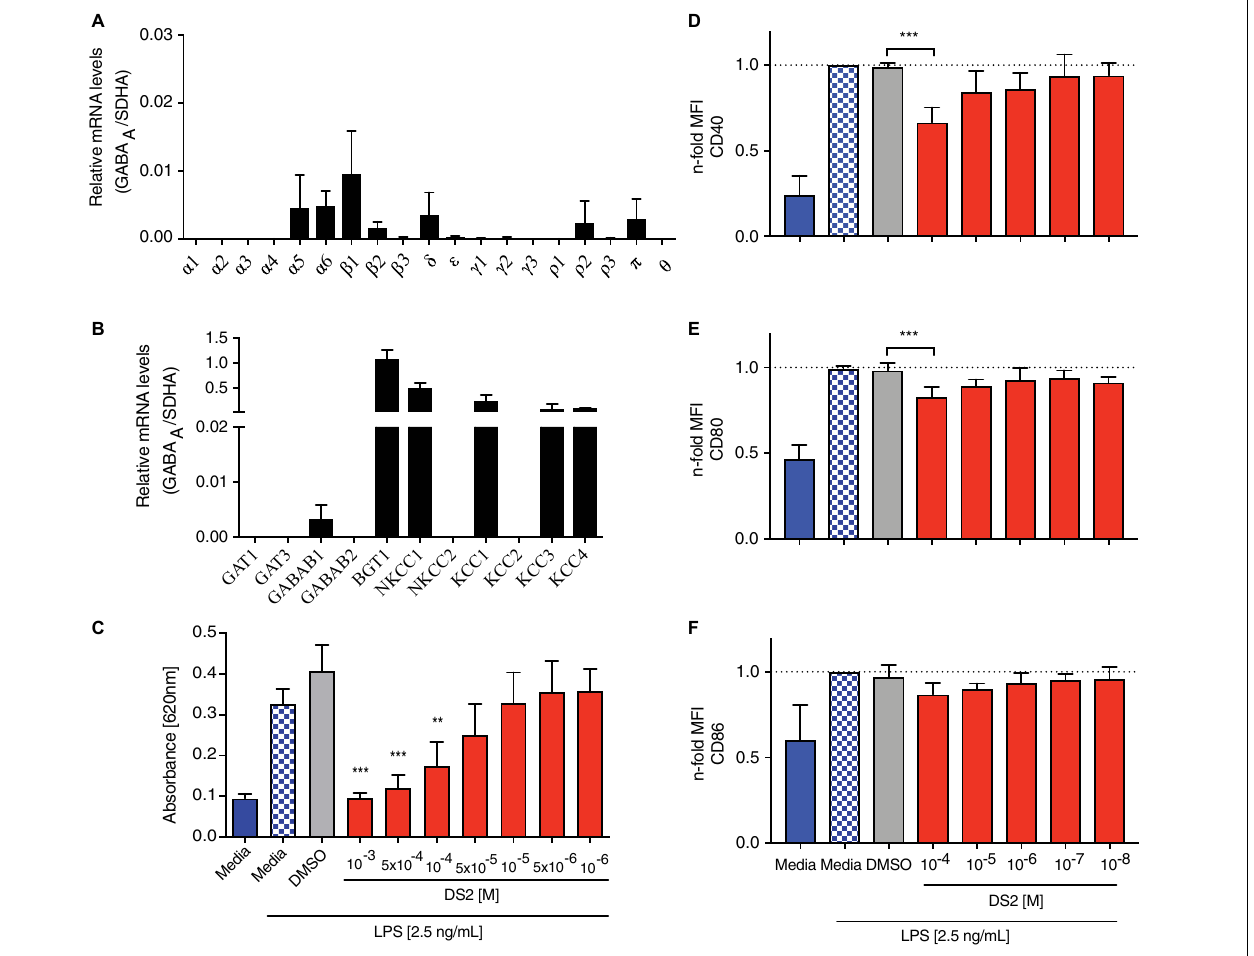
FIGURE 2 | DS2 dampens activation of innate immune cells after an inflammatory stimulus. (A,B) Expression of GABA receptor subunits by RAWblue macrophages was analyzed by qPCR. Relative mRNA levels of (A) GABA receptor subunits and (B) transporters involved in GABA signaling on unstimulated RAWblue macrophages in relation to the reference gene succinate dehydrogenase complex subunit A (SDHA) are shown. (C) RAWblue macrophages (5 × 10 4 cells/well) were either pre-treated with DS2 (10 − 3 to 10 − 6 M) or DMSO (2.5%) for 30 min or left un-treated before stimulation with LPS (2.5 ng/mL) for 6 h. Cell supernatants were collected and the extent of NF- κ B activation was determined by quantifying the reporter protein SEAP with the Quantiblue TM assay. (D–F) BMDCs were incubated with decreasing concentrations of DS2 (10 − 4 to 10 − 8 M) for 30 min prior to the addition of LPS (100 ng/mL) to the cultures. BMDCs were harvested 24 h later and expression of cell surface markers CD40, CD80 and CD86 on live, CD11c + MHCII + BMDCs was determined by flow cytometry. MFI shown as n-fold increase over LPS-treated cells. Results are the mean ± SD of three independent experiments with three replicates each. ∗∗∗ P < 0.001 and ∗∗ P < 0.01.